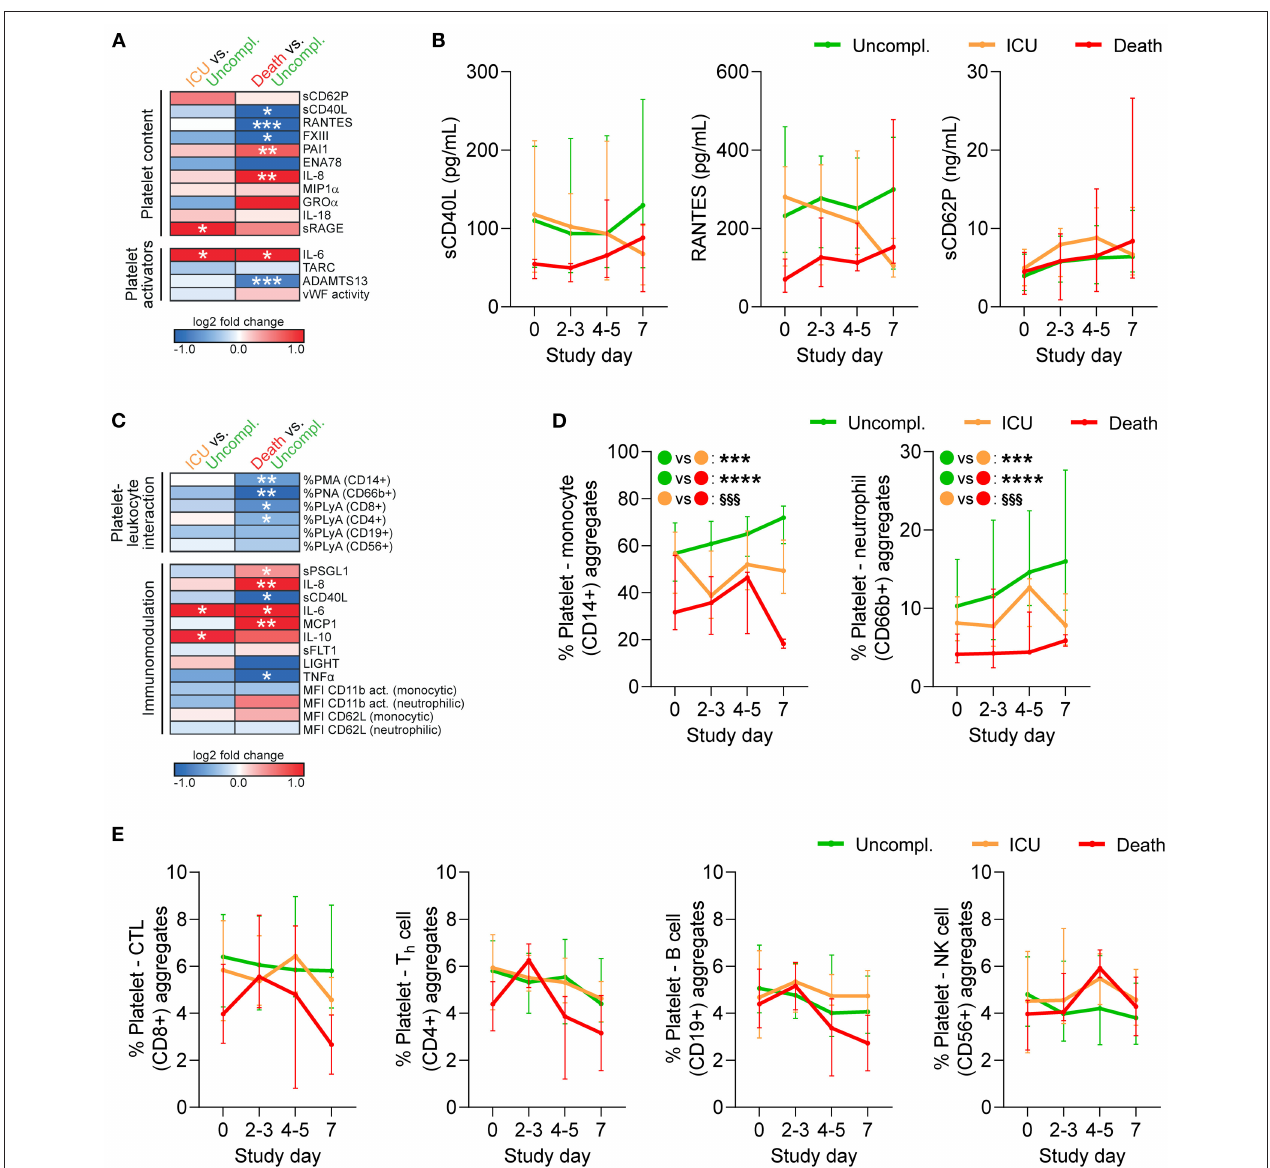
FIGURE 4 | Reduced platelet-derived plasma factors and platelet-leukocyte interaction in COVID-19 patients with fatal outcome. Whole blood ( n = 97 patients) and plasma ( n = 106 patients) was analyzed by flow cytometry, multiplex analysis and ELISA (A,B) for platelet-contained and platelet-activating mediators and (C-E) for platelet-leukocyte aggregates (PLA) and markers of platelet-mediated immunomodulation. (A,C) Heatmap visualization of expression profiles at study day 0 in patients requiring ICU treatment or with fatal outcome relative to patients with uncomplicated disease. Data are represented as log2-fold change relative to uncomplicated disease. (B) Plasma levels of soluble CD40L (sCD40L), regulated upon activation, normal T cell expressed and secreted (RANTES/CCL5) and sCD62P were monitored over 1 week after study entry. (D,E) Percentages of PLA in whole blood were monitored over 1 week after study entry. (D) PLA formation with CD14 + monocytes and CD66b + neutrophils. Asterisks (*) indicate significant differences to uncomplicated, section signs ( § ) indicate significant differences between ICU and death. (E) PLA formation with CD56 + natural killer (NK) cells, CD19 + B cells, CD8 + cytotoxic T-lymphocytes (CTL) or CD4 + T-helper (T h ) cells. n = 106 (plasma content) or 97 (cell analysis) patients. MFI, mean fluorescence intensity; PMA, platelet-monocyte aggregates; PNA, platelet-neutrophil aggregates; PLyA, platelet-lymphocyte aggregates. * p < 0.05, ** p < 0.01, *** p < 0.001, **** p < 0.0001; §§§ p <